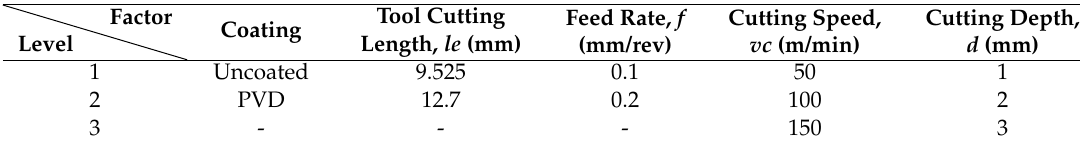
Table 4. Factors and levels of the design of